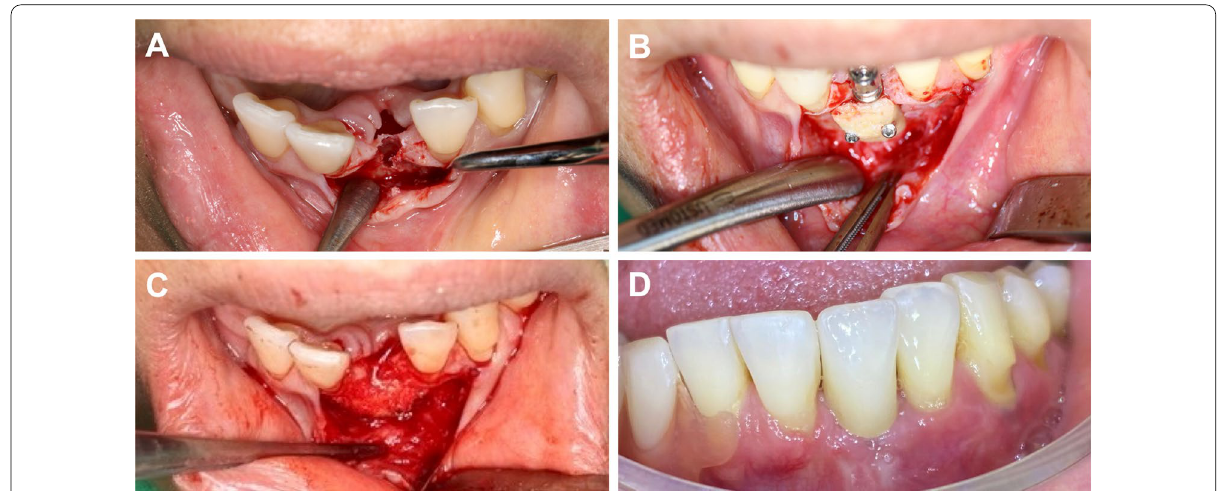
Fig. 3 Clinical example of a 41‑year‑old female patient presenting with missing tooth 31 and consecutive horizontal bone loss ( A ). For dental, functional and esthetic rehabilitation, simultaneous implant placement and lateral augmentation was performed. Implantation of Conelog Progressive Line, harvesting of a retromolar bone block from the mandibular angle with a trephine drill, augmentation and microscrew fixation (1.0‑mm steel screws) after rounding of the edges with a burr ( B ). Relining and fitting with particulate bone placement ( C ). After 5 months of healing time, implant exposure and fixation screw removal, sequential abutment fitting and placement of dental crown were performed ( D